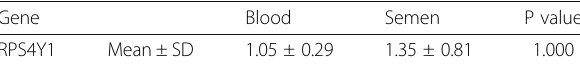
Table 8 Spearman ’ s correlation between participants ’ age and male RPS4Y1 in the studied body